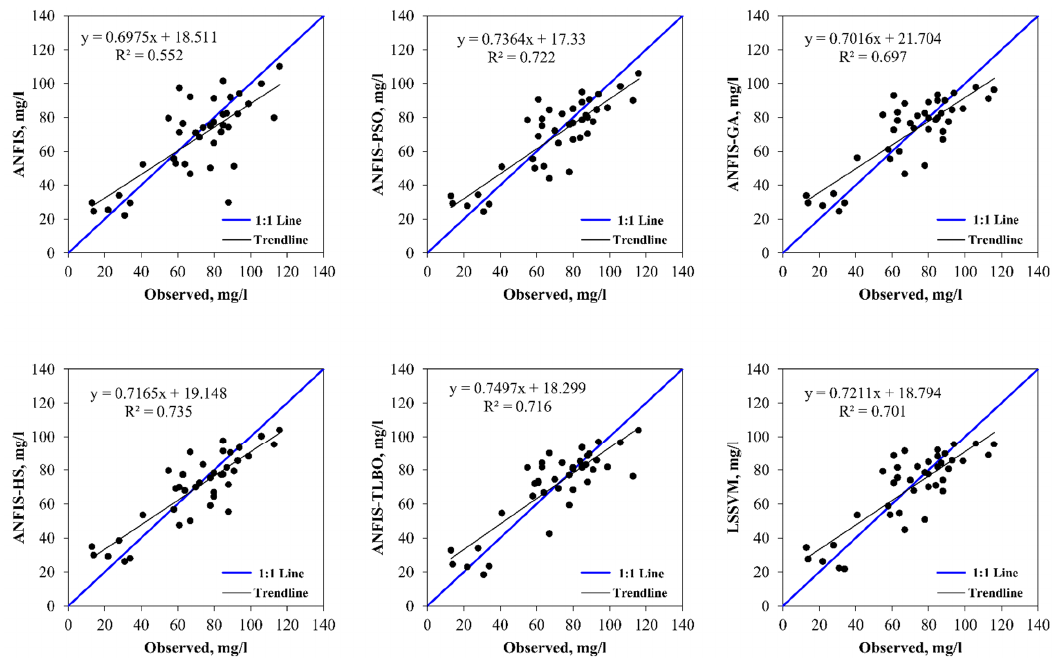
Figure 4. The observed and model-estimated CODs for the M2 data set with AMM, TKN, WT, and TC as inputs.